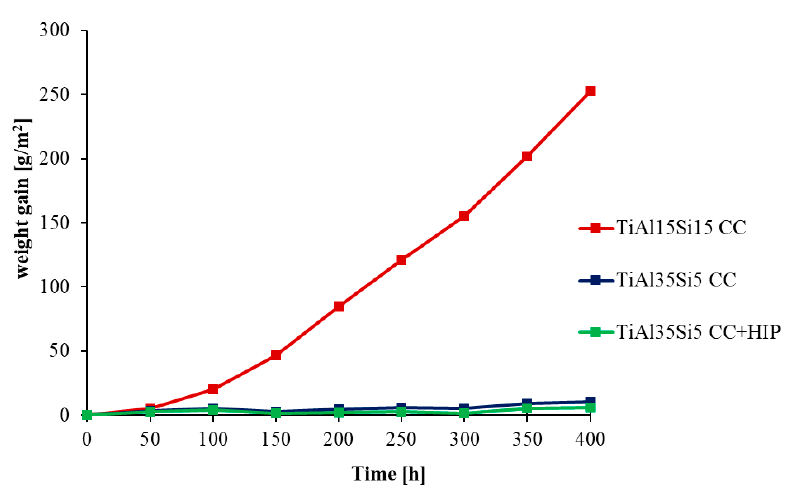
Figure 4. Dependence of total weight gain of Ti-Al-Si alloys (including delaminated oxides) on cyclic oxidation duration (800 °C; 400 h).